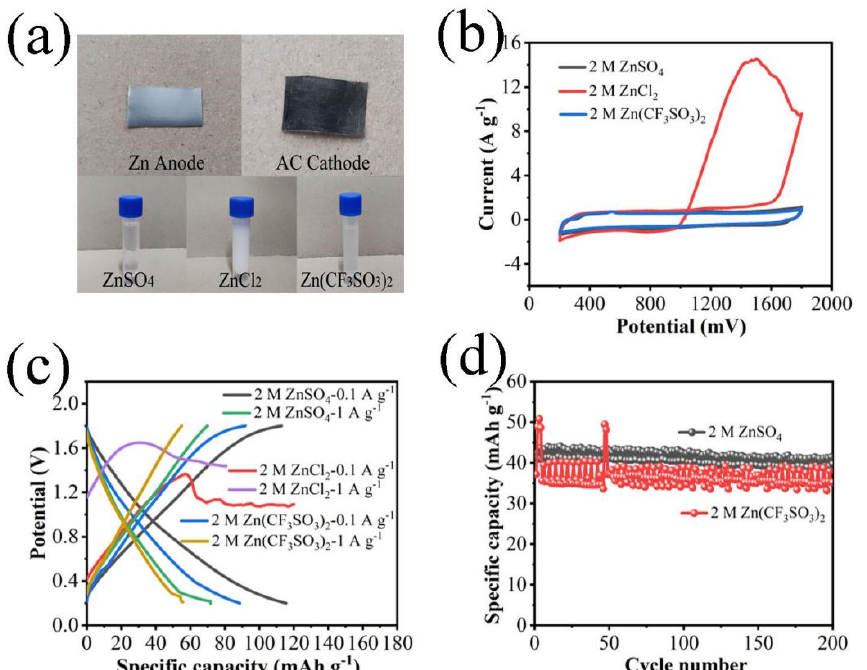
Figure 1. ( a ) Digital photographs of the Zn anode, AC cathode, and 2 M ZnSO 4 , 2 M ZnCl 2 , and 2 M Zn(CF 3 SO 3 ) 2 electrolytes; ( b ) Comparison of three CV curves (5 mV s − 1 ); ( c ) Rate capabilities of three electrolytes at 0.1 and 1 A g − 1 current densities; ( d ) Cycling performances (5 A g − 1 ) of 2 M ZnSO 4 and 2 M Zn(CF 3 SO 3 ) 2 electrolytes.